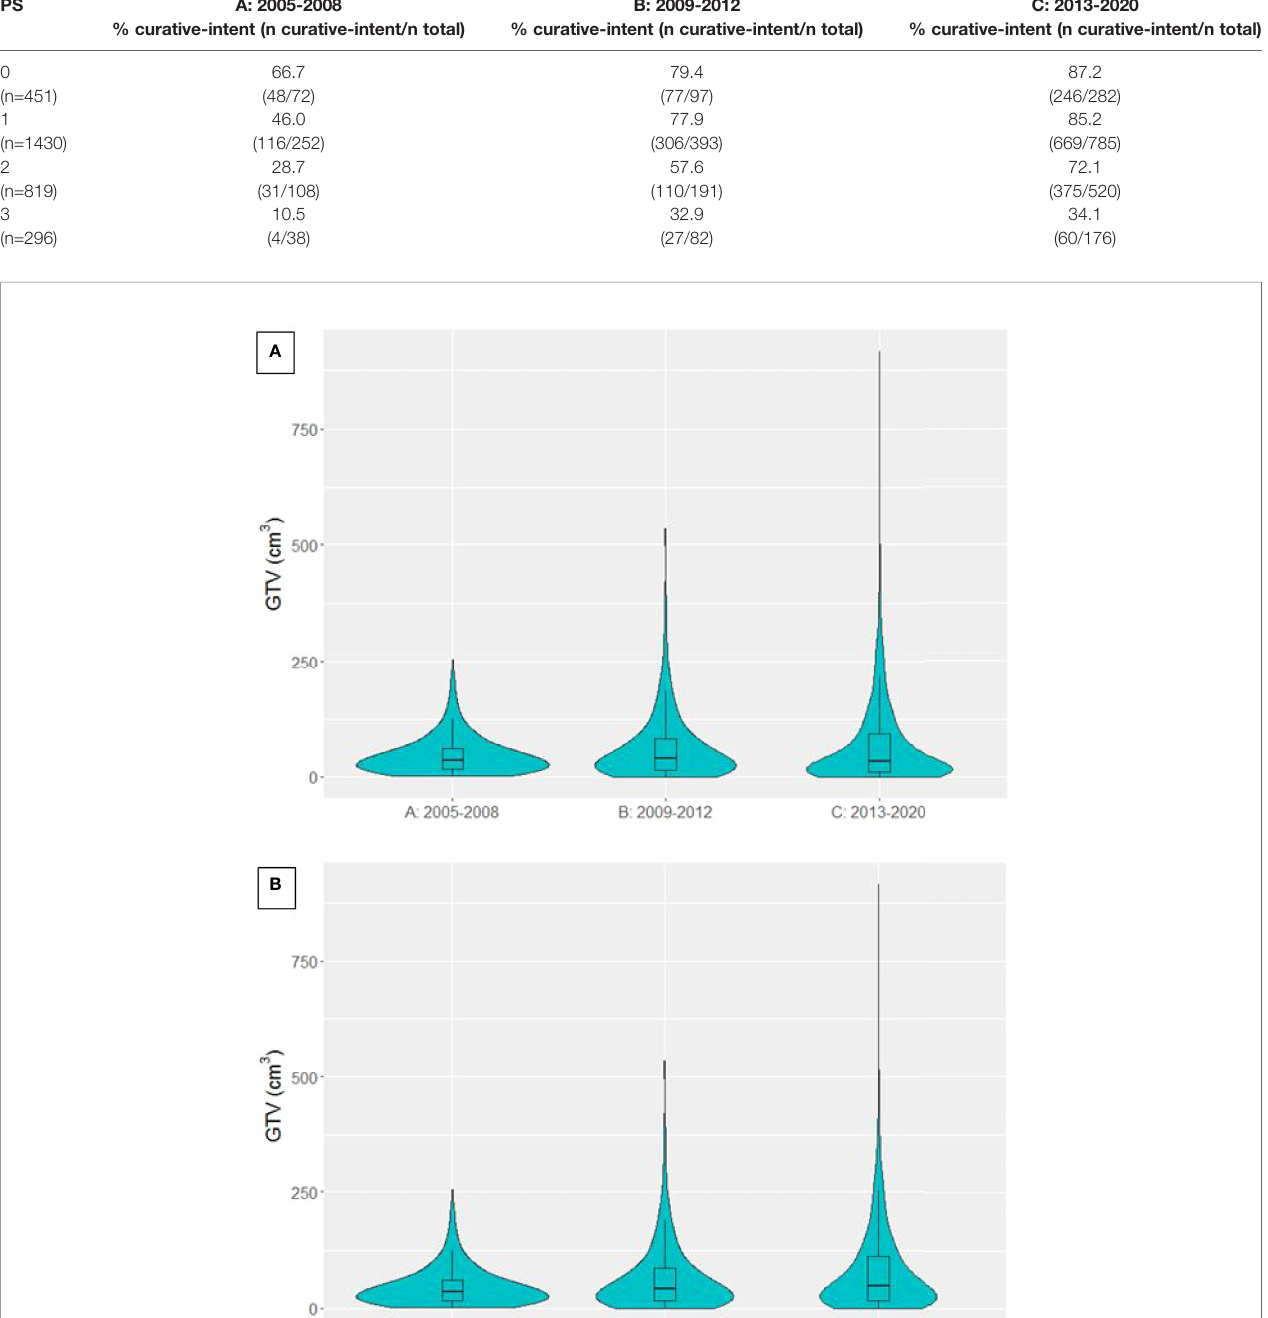
TABLE 4 | Proportion of patients treated with curative-intent radiotherapy across each PS and time period for stage III patients only.